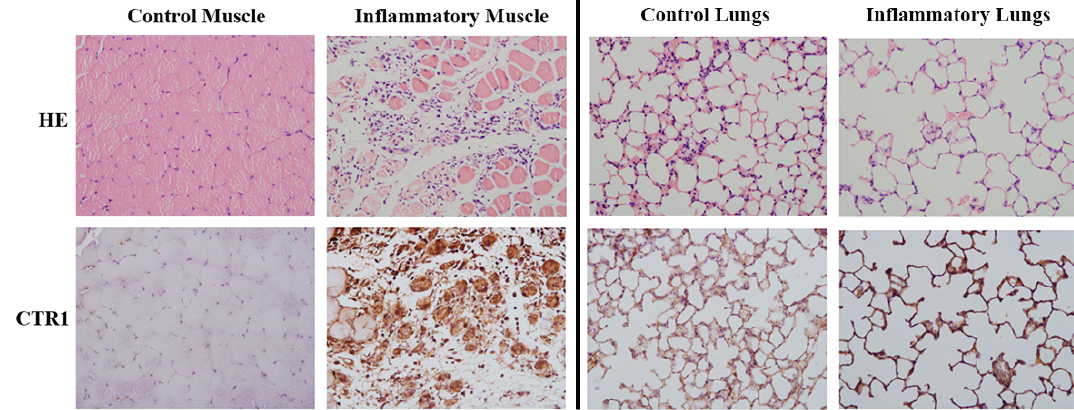
Figure 3. Microscopically, H&E and immunohistochemical CTR1 staining of the control muscle and inflammatory muscle ( Left ), and control lungs and inflammatory lungs ( Right ) (original magnification ×100).